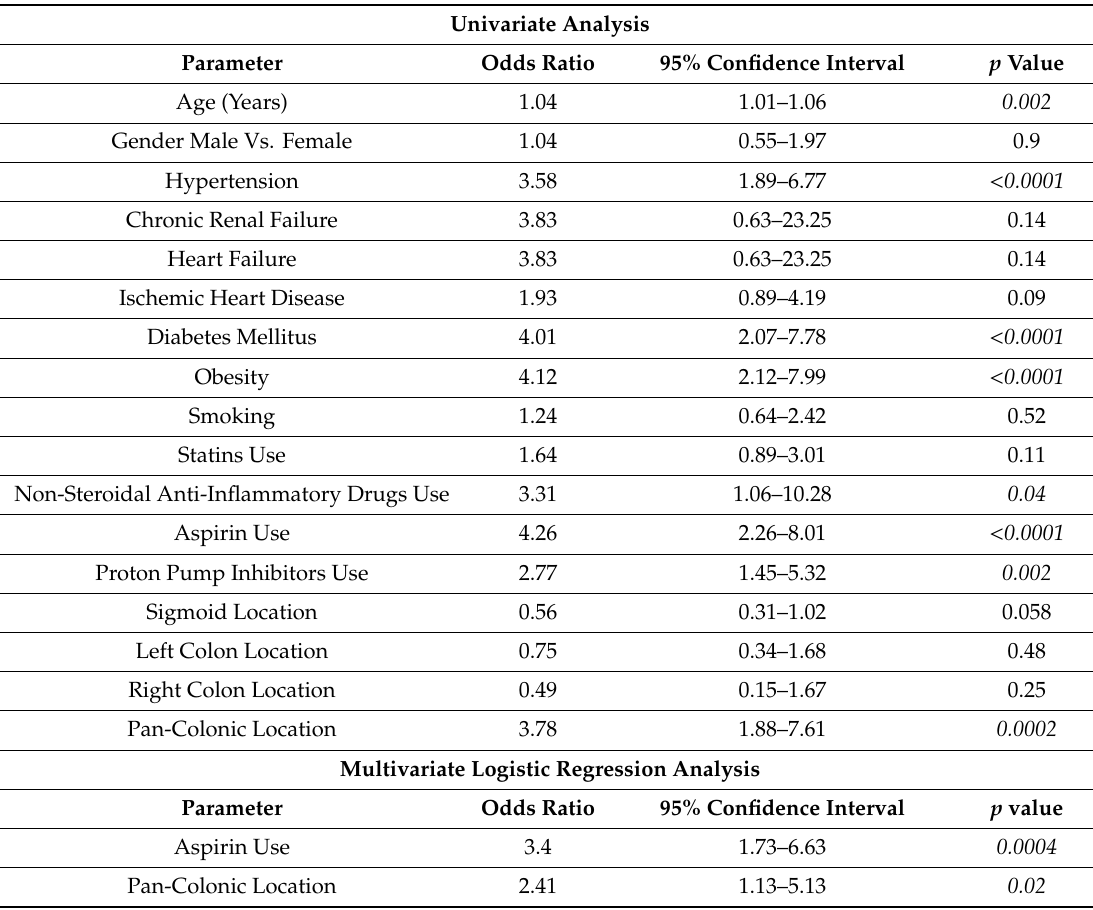
Table 5. Univariate and multivariate analyses of parameters associated with higher diverticulitis severity (Hinchey stage